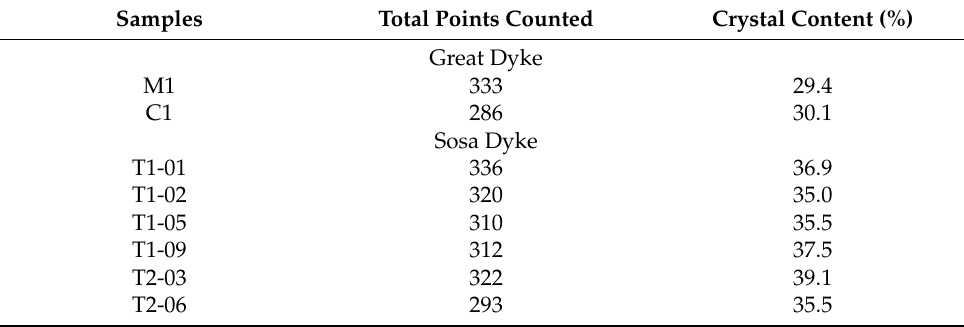
Table A3. Point counting results from thin sections